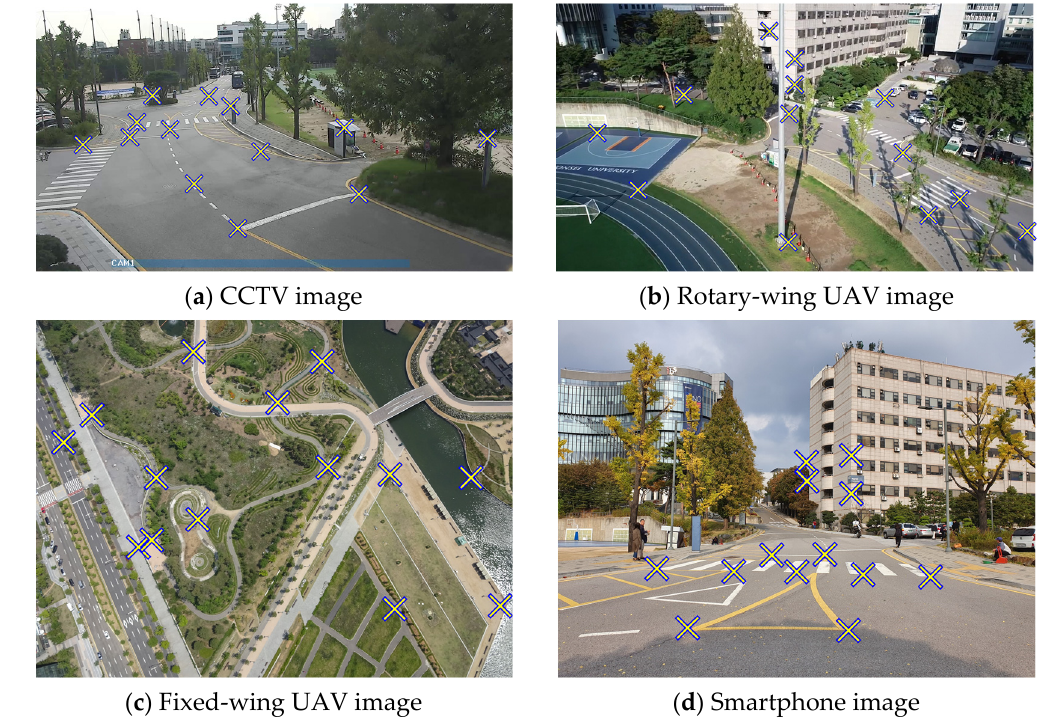
Figure 4. Images from each sensor platform.